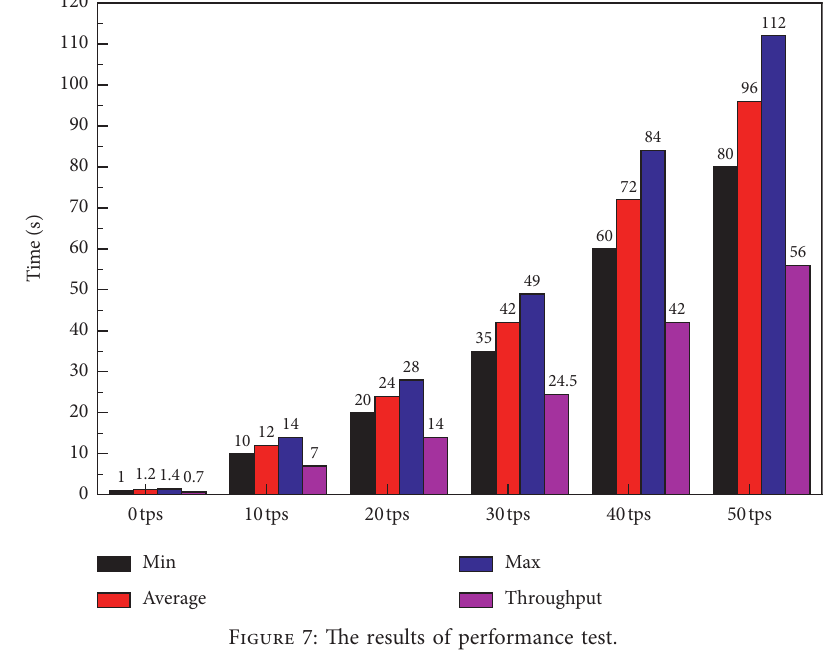
Figure 7: The results of performance test.